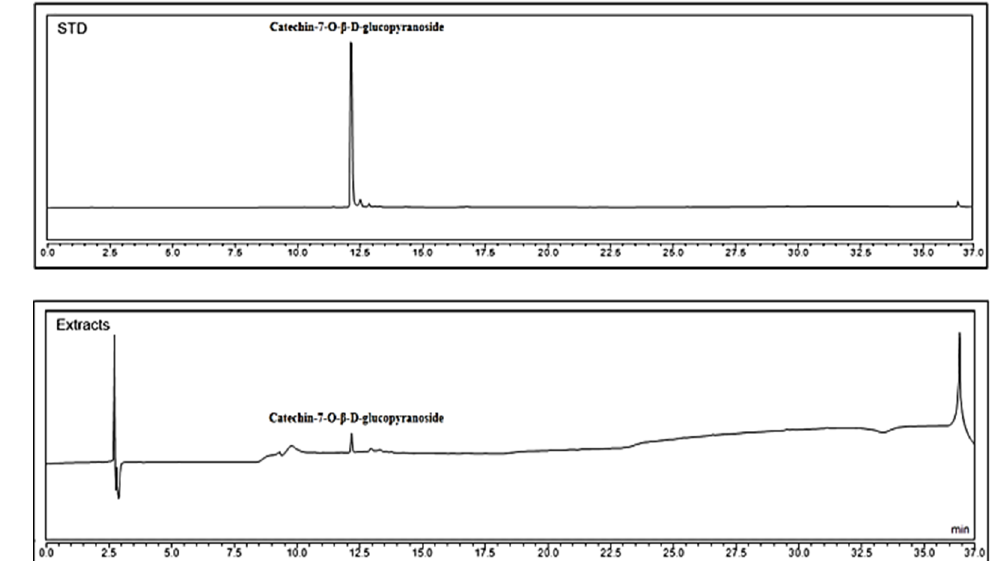
Figure 1. HPLC analysis of PASE: HPLC analysis of catechin-7-O- β -D-glucopyranoside standards ( a ) and the catechin-7-O- β -D-glucopyranoside content of PASE ( b ).